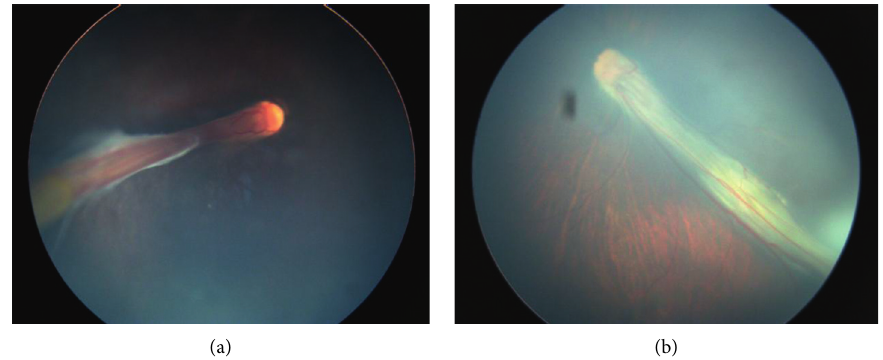
Figure 4: (a) Right eye fundus of case 8. (b) Left eye fundus of case 9. Stage 4b lesions were mostly manifested as falciform fold of the retina.